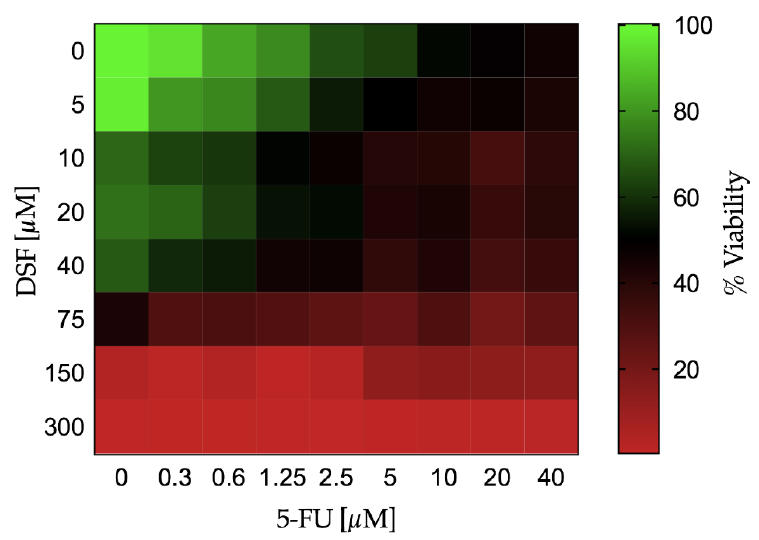
Figure 10. The combined effect of DSF and 5-FU on cell viability of Ca-Ski cells depicted using a heat map.